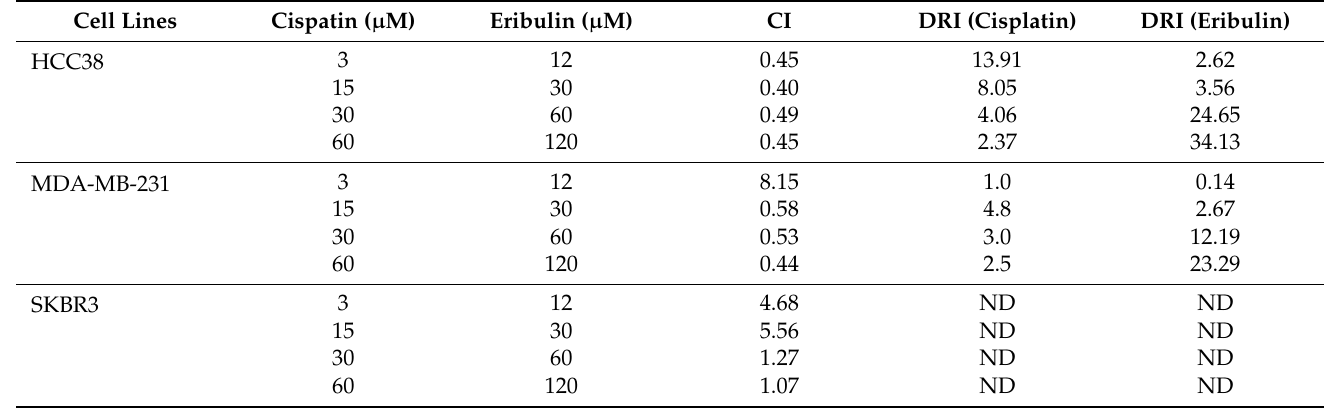
Table 1. Combination index (CI) values for cisplatin and eribulin combination for breast cancer cell